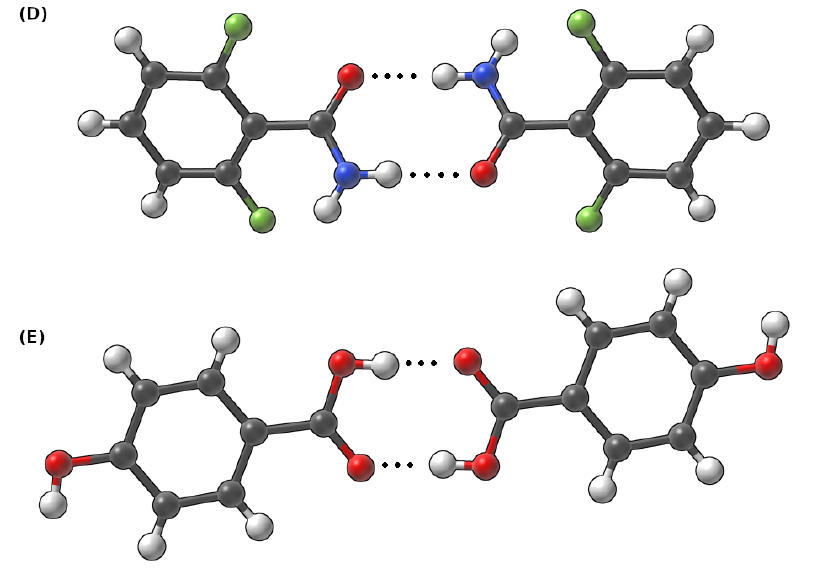
Figure 2. Dimers taken from the crystalline phase of ( D ) 2,6-difluorobenzamide and ( E ) 4- hydroxybenzoic acid to study intermolecular hydrogen bonds. Dotted line indicates the inter- molecular hydrogen